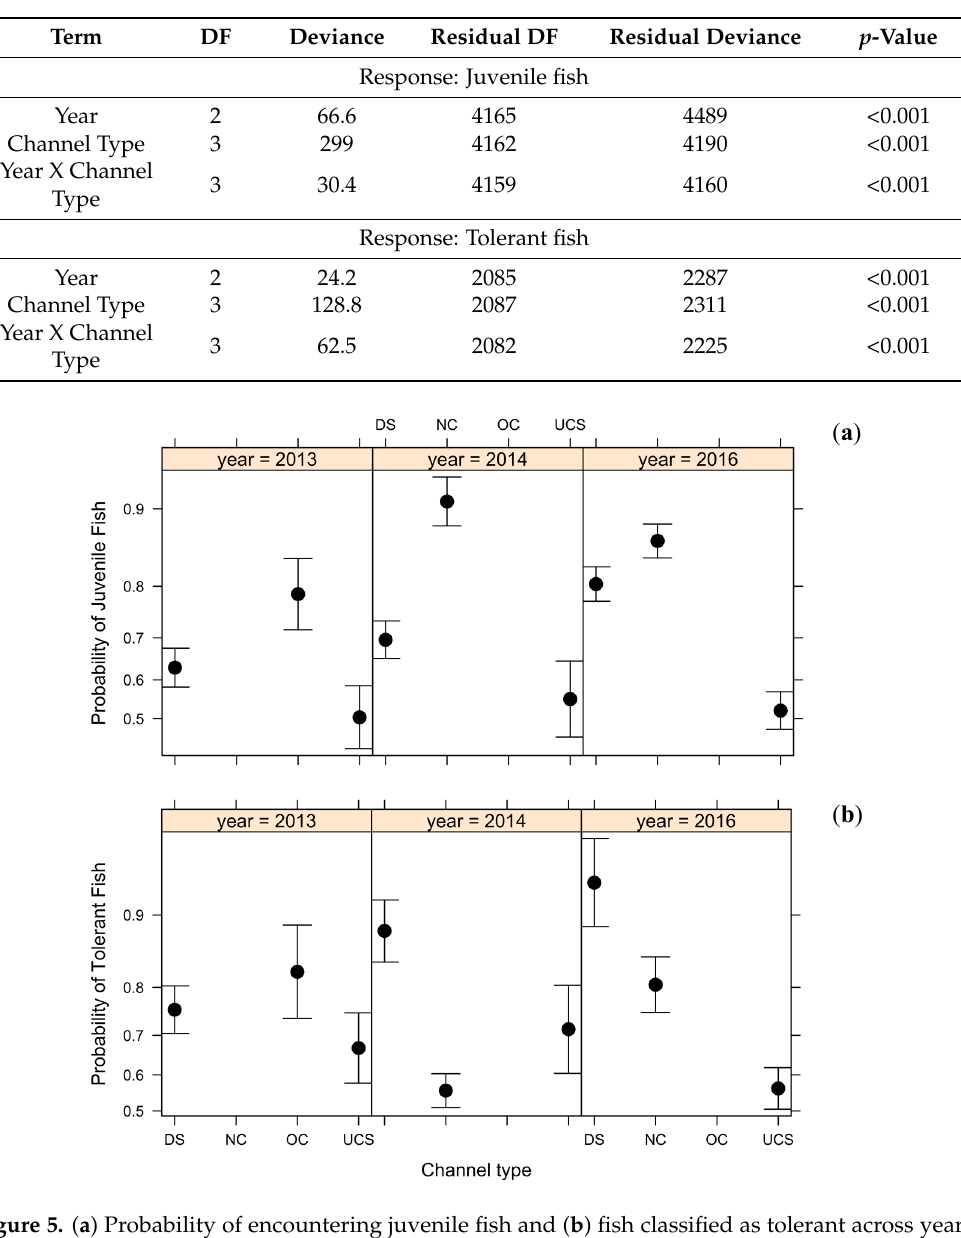
Figure 5. ( a ) Probability of encountering juvenile fish and ( b ) fish classified as tolerant across years and channel types, where DS are sites downstream of the newly reconfigured channel, NC are new channel sites, OC are old channel sites, and UCS is the upstream control site. Error bars represent 95% confidence intervals.